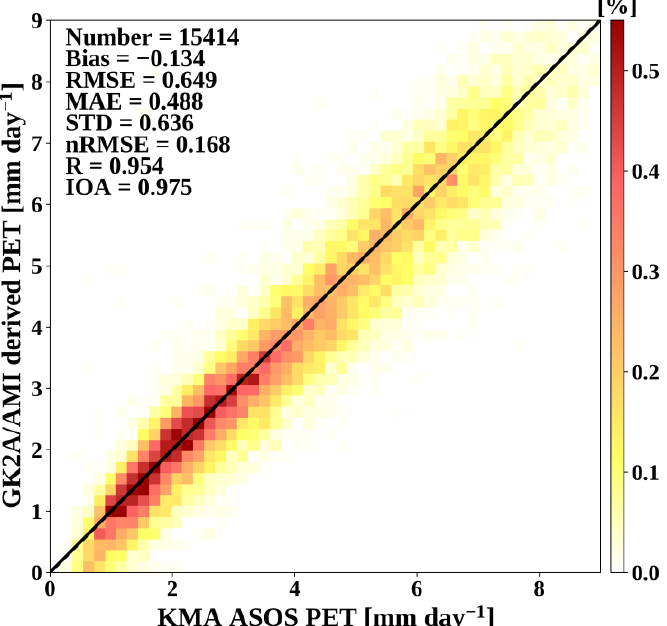
Figure 7. Comparison between GK2A/AMI satellite-derived PET estimates and PM-ET from ASOS stations operated by KMA, for the period 25 July 2020 to 31 July 2021. The color represents the proportion of the data relative to the total number of matchups.